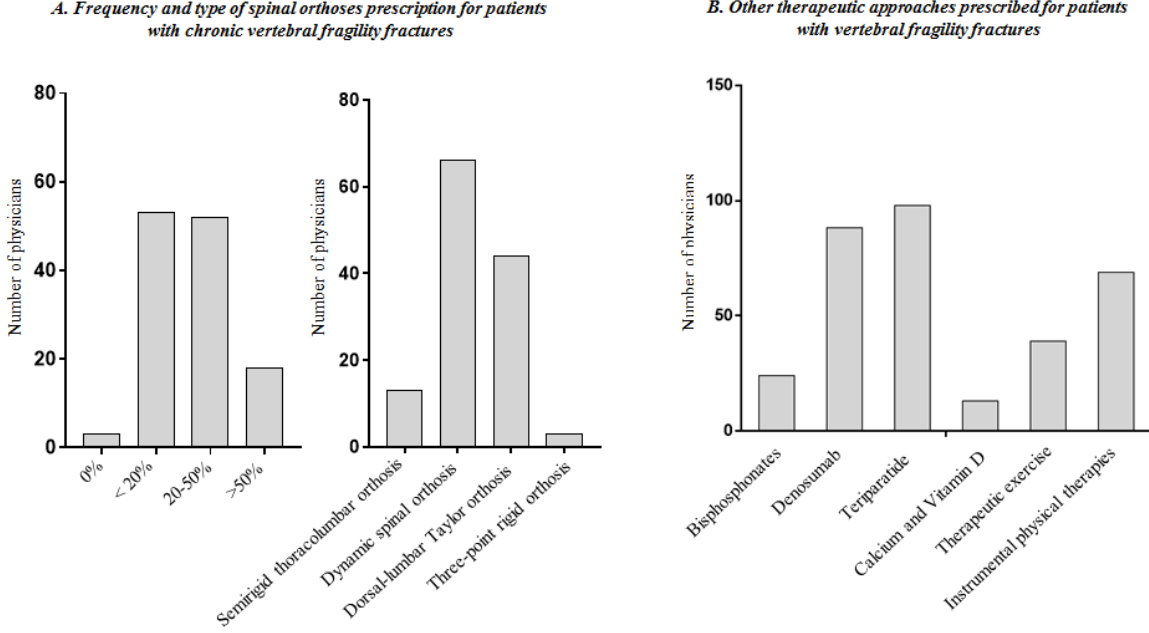
Figure 2. Information on prescription by the physicians in patients with back pain without vertebral fragility fractures and with acute vertebral fragility fractures (questions included in the domains D and E of the survey).